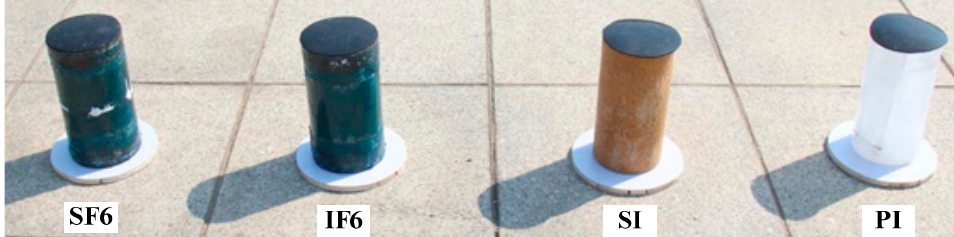
Figure 4. Melting specimens.